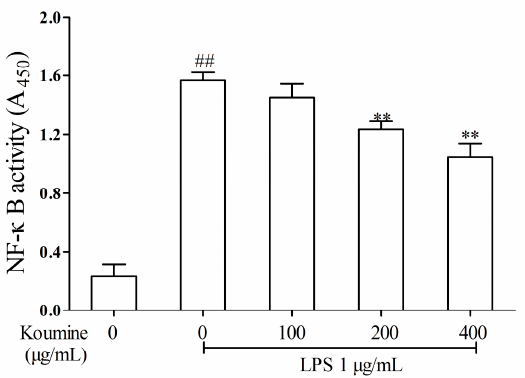
Figure 6. Effect of koumine on NF- κ B activity in LPS-stimulated RAW264.7 cells. Cells were pretreated with 100, 200 or 400 μ g/mL koumine for 6 h. Subsequently, cells were treated with 1 μ g/mL LPS in the mediums containing koumine for 1 h. The nuclear protein extracts were used to measure DNA-binding activity of NF- κ B by the Trans AM TM kit for p65. The data were expressed as mean ± standard deviations (SD) ( n = 3). ## p < 0.01 vs. control group; ** p < 0.01 vs. LPS group.